Question: In one sentence, what is this figure communicating?
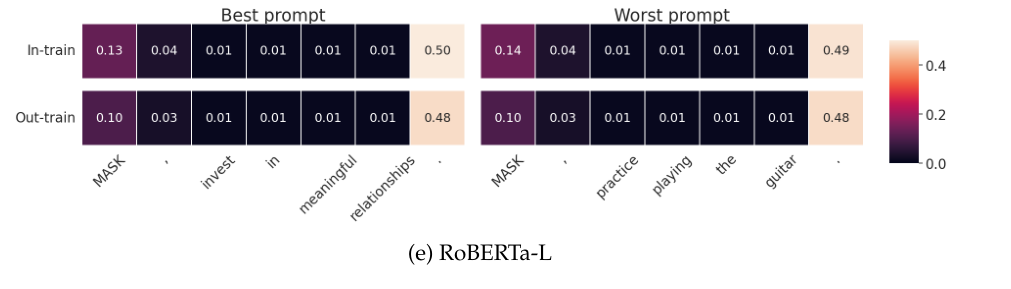
Answer: Attention heatmaps of the best and the worst prompts across 5 models on the dev set averaged over all attention heads and layers. The attention weights corresponding to each prompt’s “MASK” token are used and averaged over the In-train and Out-train PER sets separately.